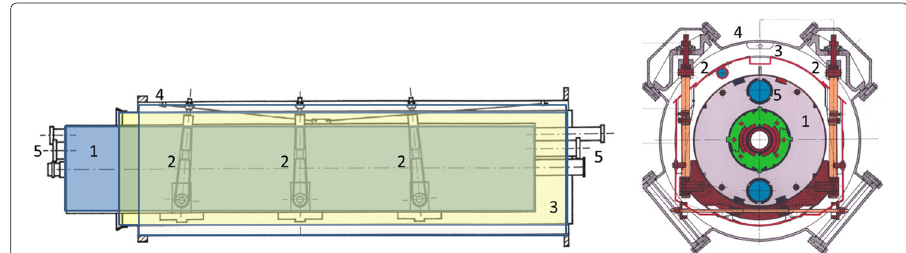
Fig. 4 Schematic view of the HERA dipole. 1 Helium vessel containing cold mass, 2 Suspension, 3 Radiation shield, 4 Vacuum vessel, 5 Helium